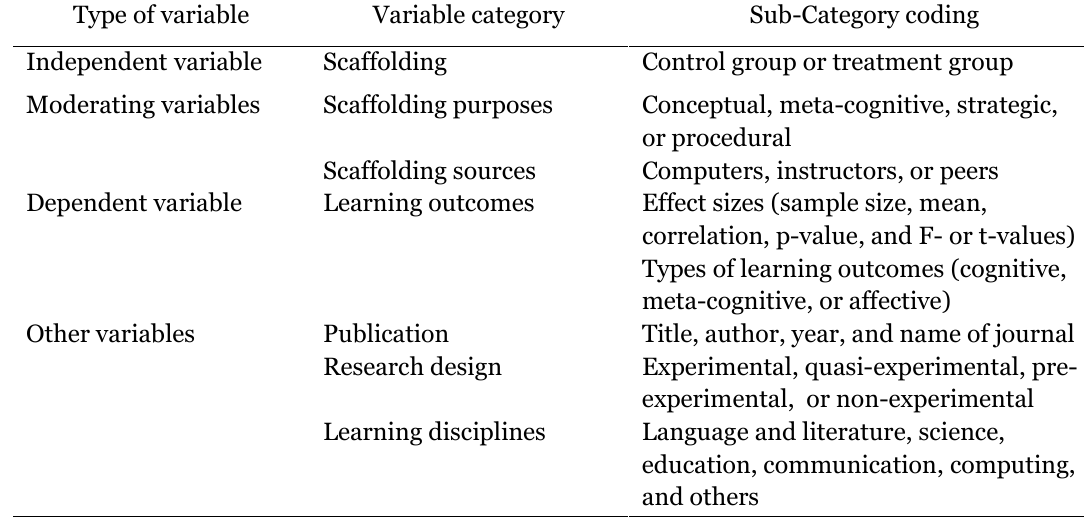
Table 1 Coding Information for Meta-Analysis Type of